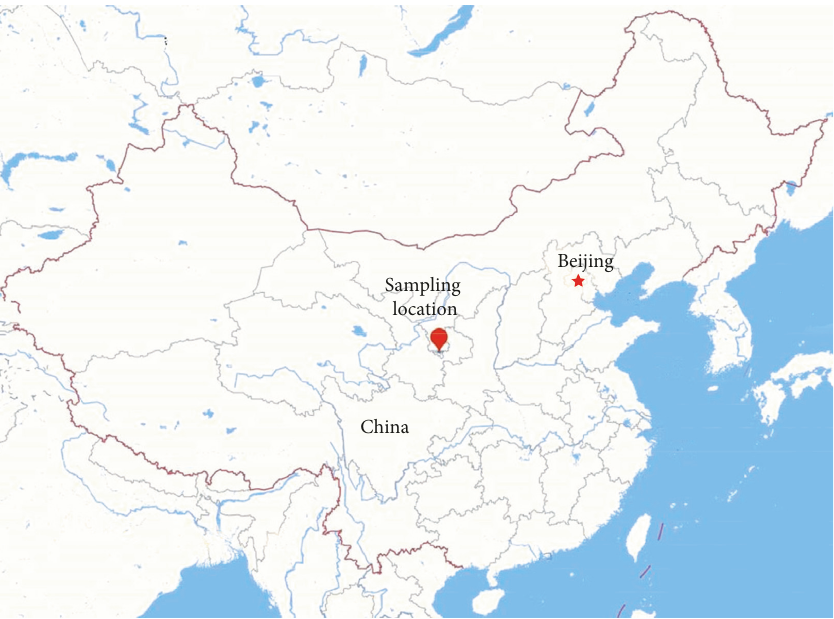
Figure 1: Sampling location of argillaceous limestone in this study. Table 1: Chemical compositions of argillaceous limestones.